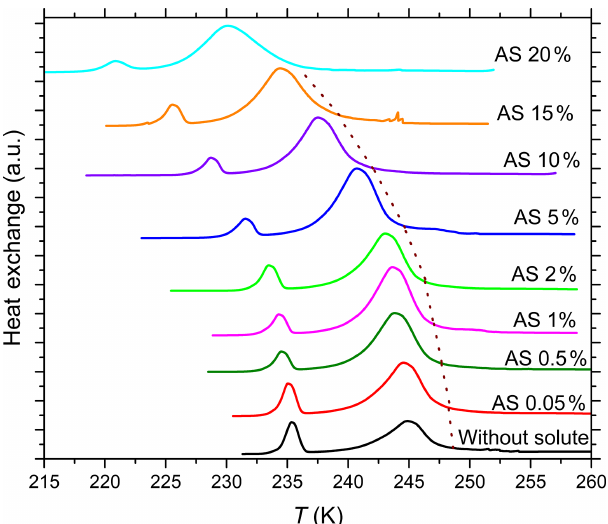
Figure 3. DSC thermograms of 5wt% SA quartz particles sus- pended in ammonium sulfate (AS) solution droplets of increas- ing concentrations (0wt%–20wt% AS). All curves are normal- ized such that the areas under the heterogeneous and homogeneous freezing curves sum up to the same value. The dotted brown line connects the heterogeneous freezing onset temperatures ( T het ) of the emulsions. With increasing AS concentration T het decreases monotonically while the intensity of the heterogeneous freezing sig- nal increases initially in dilute AS solution and remains high up to high solute concentrations.